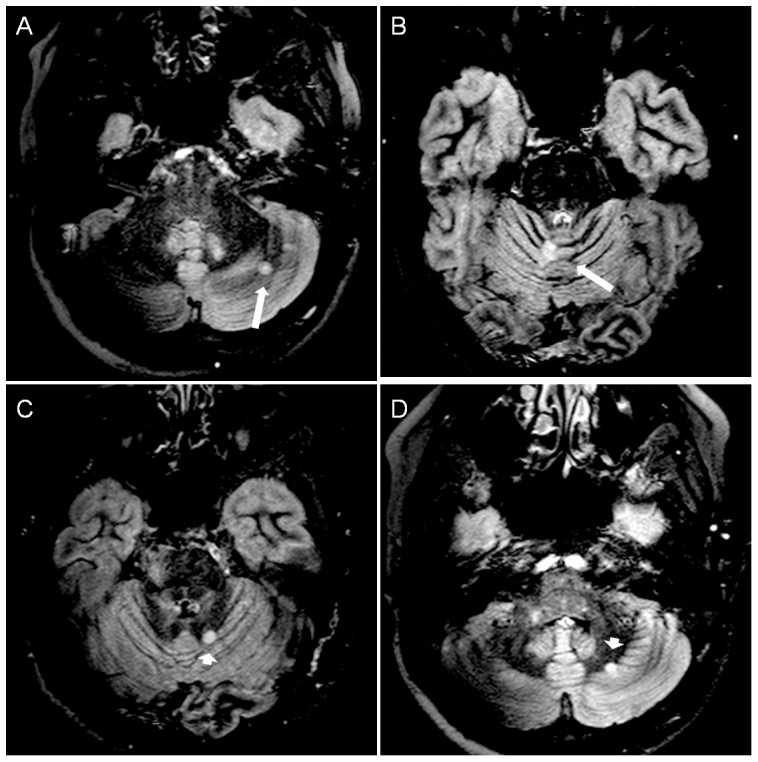
Cerebellar intracortical and leukocortical lesions.Axial double inversion recovery images from relapsing-remitting MS patients showing intracortical (long arrows, A and B) and leukocortical lesions (short arrows, C and D).